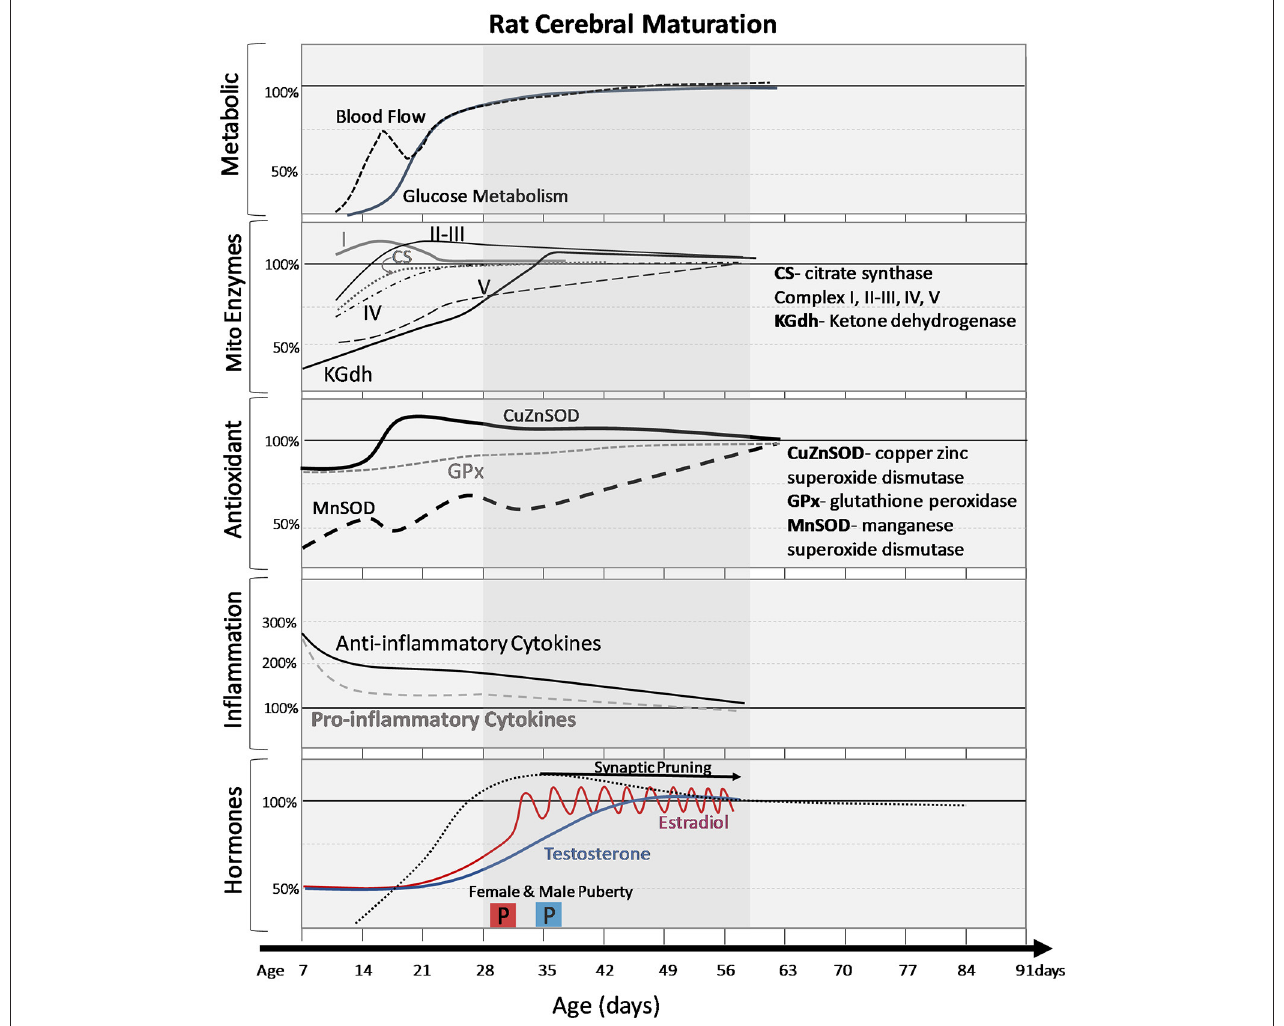
FIGURE 2 | Normal cerebral changes in metabolic markers, mitochondrial enzymes, antioxidants, inflammatory signals, and hormones with postnatal age (days). The shaded age range reflects adolescent time period. Changes are expressed as percentage of adult values. Pro and anti-inflammatory cytokines are averages of multiple cytokines to demonstrate general trends. Onset of puberty (2 boxes labeled “P”) is earlier in females (pink box) than males (blue box) and the differences in timing of hormonal increases and patterns (gradual increase vs. pulsatile changes in